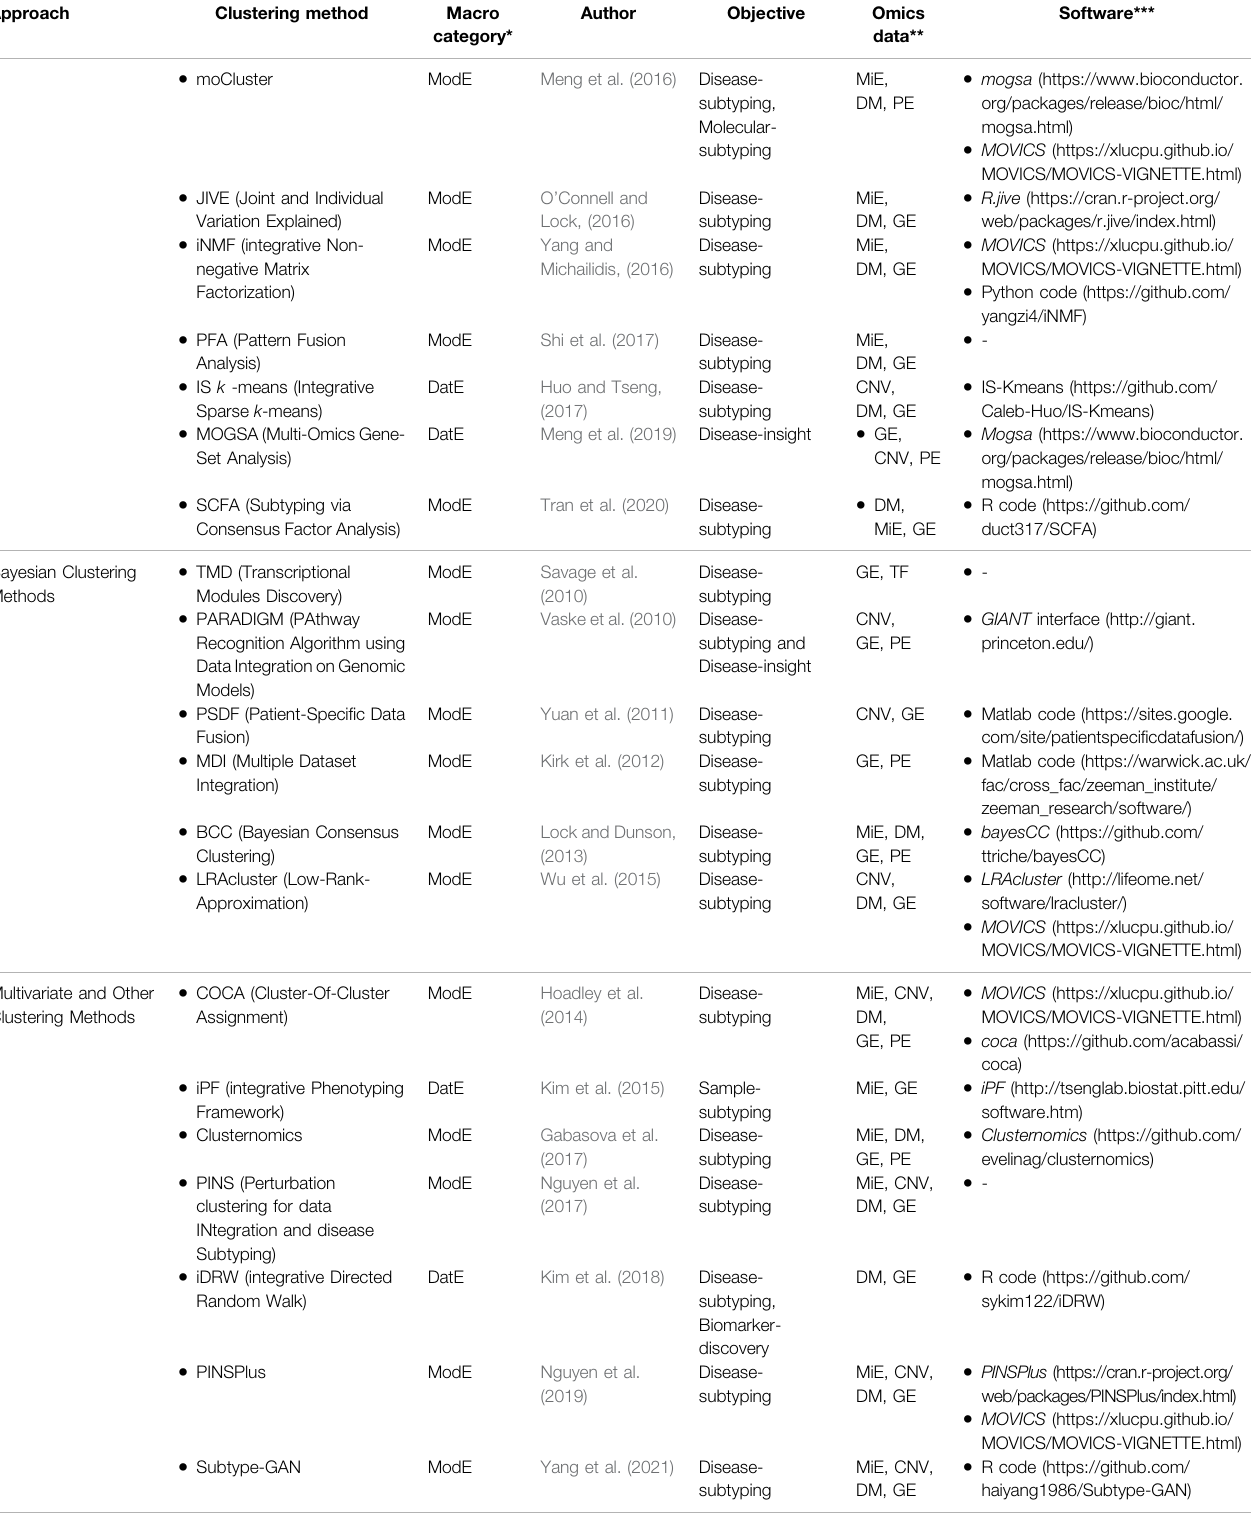
TABLE 3 | ( Continued ) Low-level: Clustering-based unsupervised integration